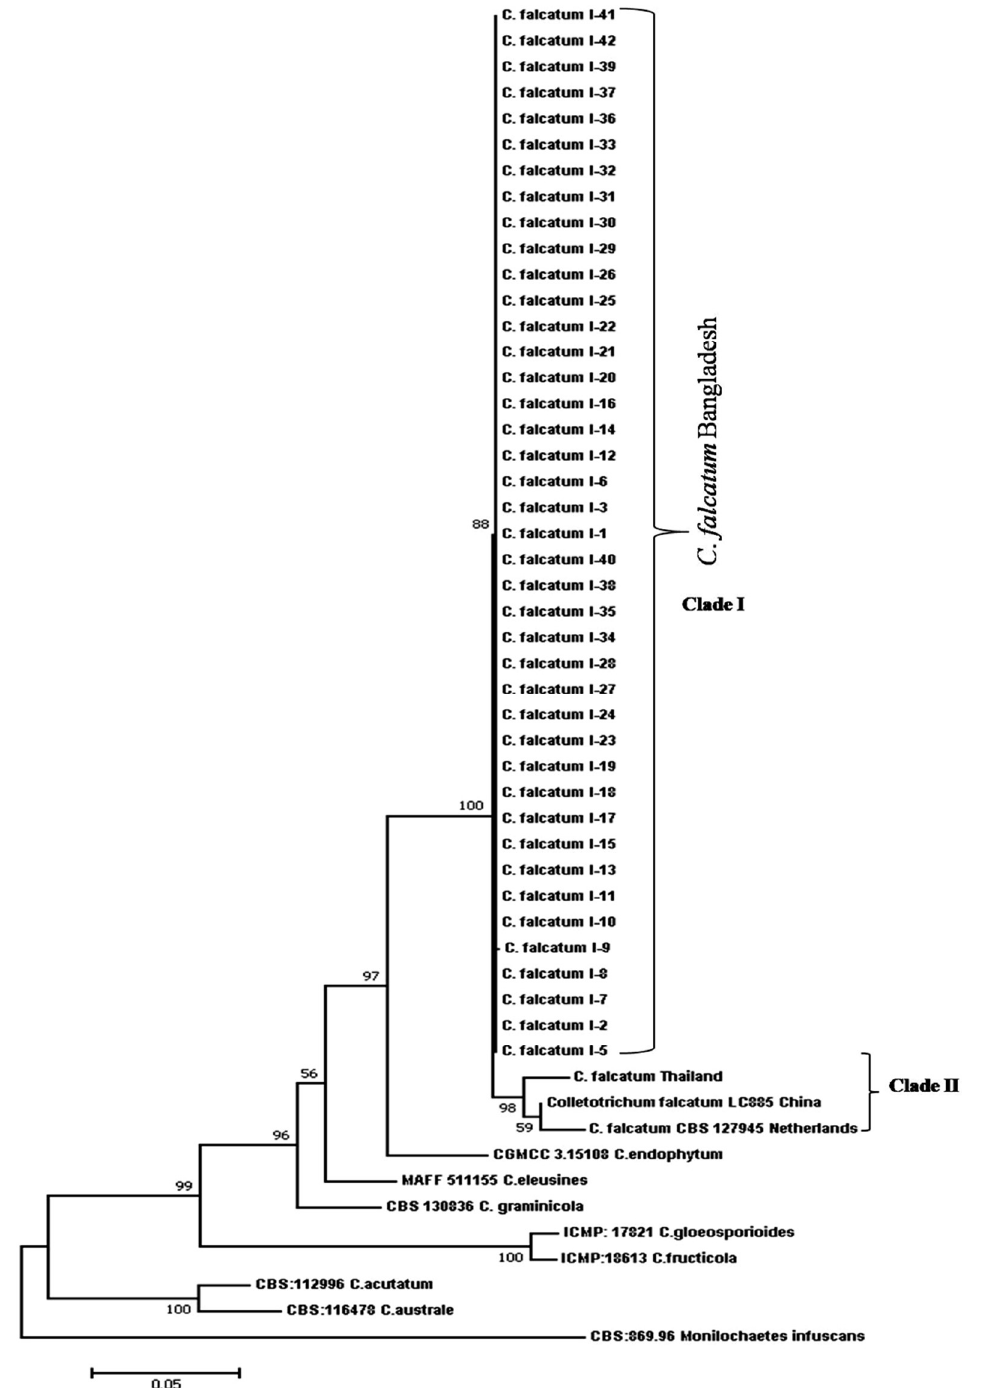
Figure 6. Phylogenetic tree of C. falcatum isolates using Maximum likelihood method based on combined ITS, β-tubulin , Actin and GAPDH sequences. The tree was rooted with Monilochaetesinfuscan. ML bootstrap value is indicated at each node.